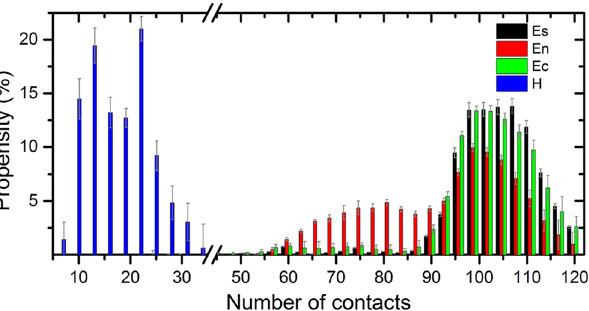
Figure 5. Propensity of inter-chain contact number in different intermediates. Es: intermediate with more than six β -sheet residues on both N-terminal (residue 8–17) and C-terminal region (residue 28–35); En: intermediate with more than six β -sheet residues on the N-terminal region; Ec: intermediate with more than six β -sheet residues on C-terminal region; H: intermediate with more than eight α -helical residues on both chains. Two inter-chain residues were defined to be contact if the distance between any heavy atoms on these residues is less than 4.5 Å. The error bars are corresponding the deviations of the propensity